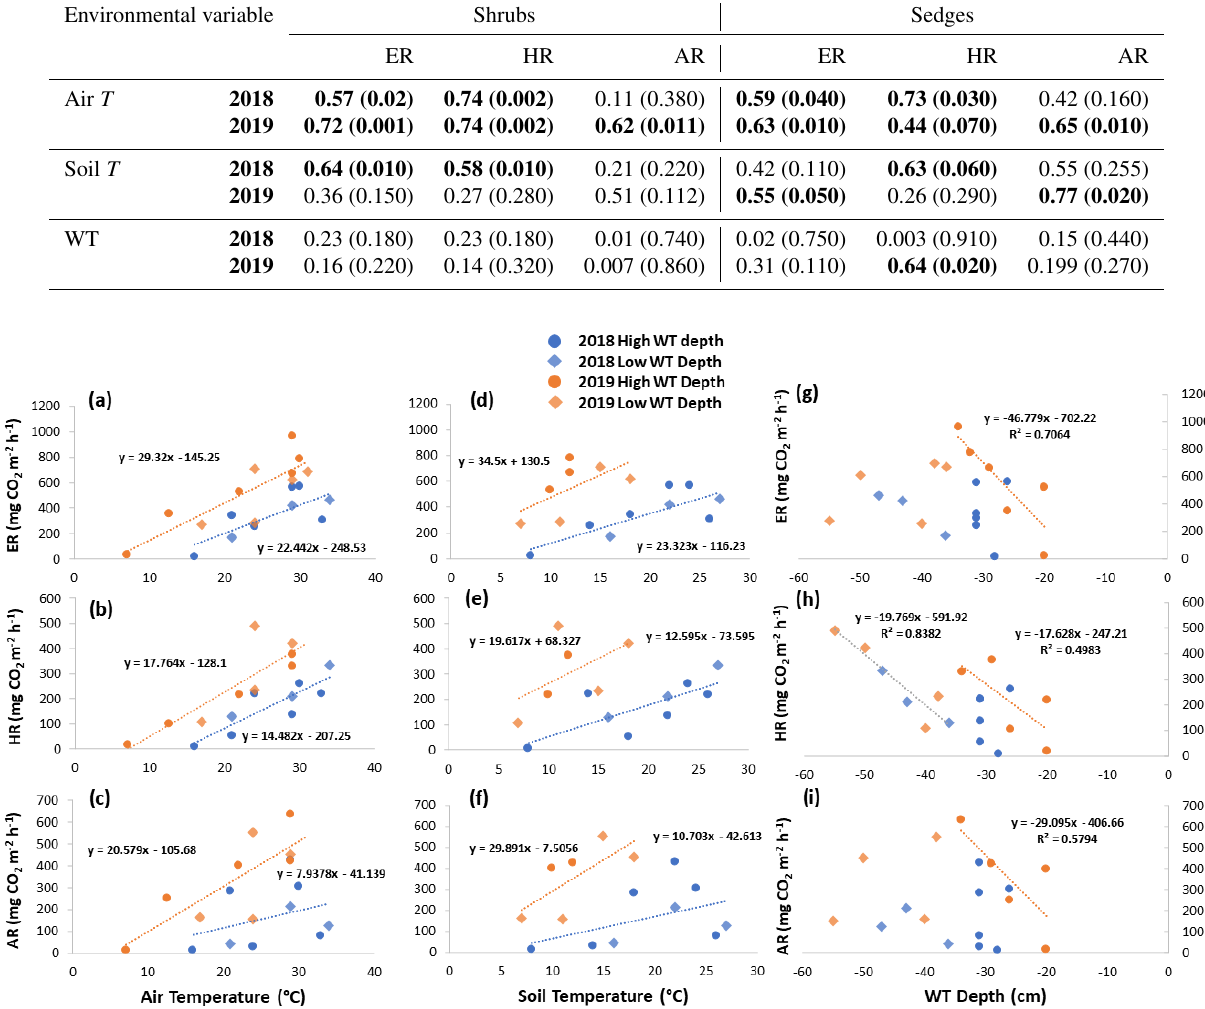
Figure 6. Scatterplots with trend lines of relationships between air temperature and (a) ER, (b) HR, and (c) AR; between soil temperature and (d) ER, (e) HR, and (f) AR; and between water table (WT) depth and (g) ER, (h) HR, and (i) AR in the shrubs across the growing seasons of 2018 and 2019. High WT refers to water table positions from surface to 35cm